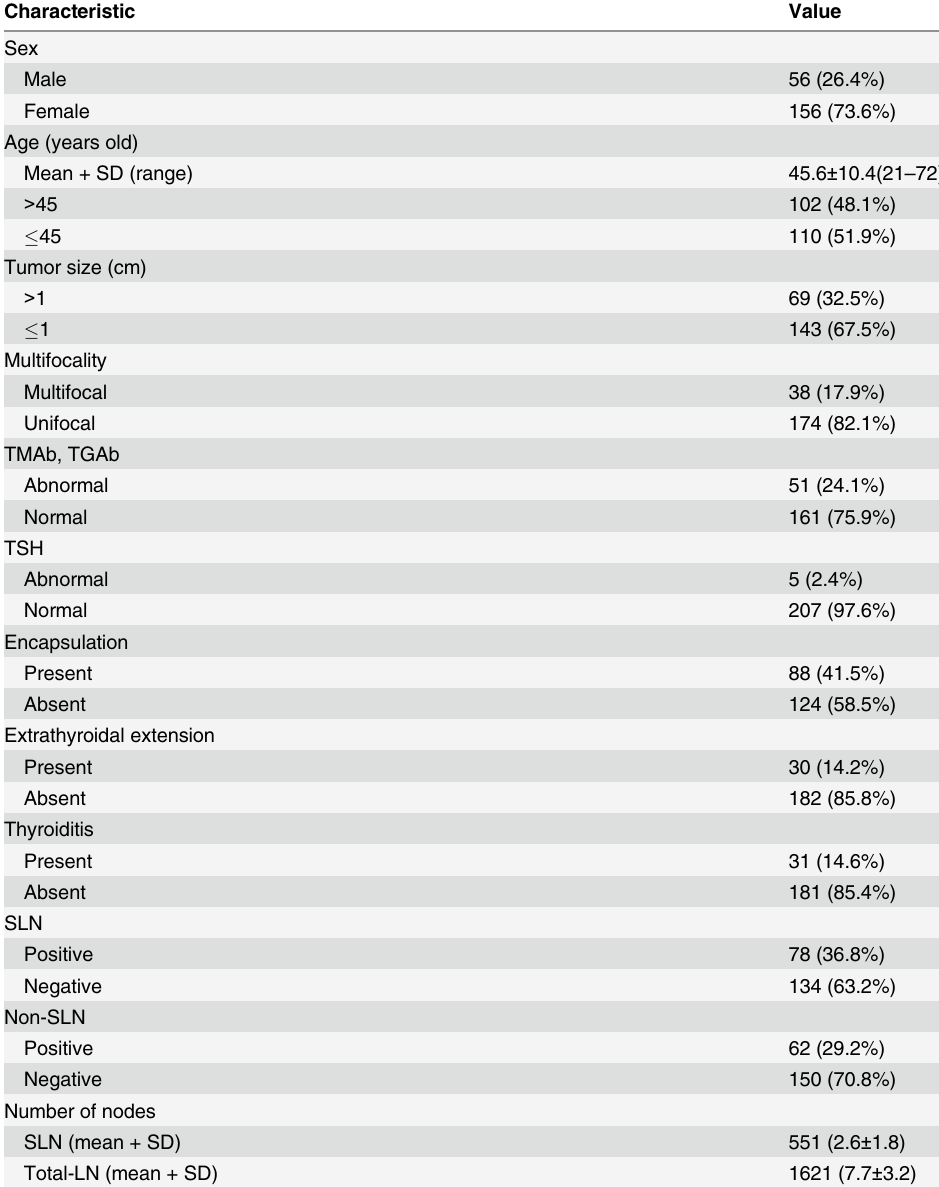
Table 1. Patient demographics and tumor characteristics (n = 212).